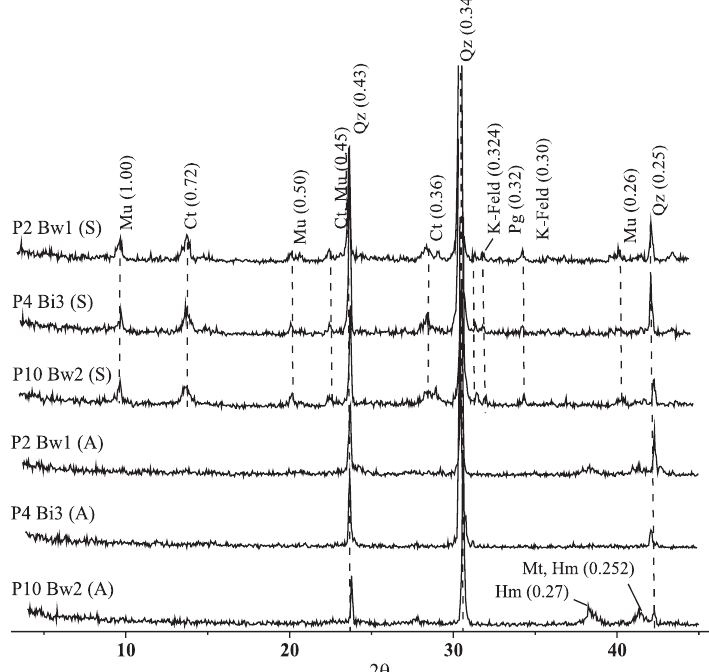
Figura 4. DRX representativos das frações silte (S) e areia (A) de LVA (P2), CX (P4) e LV (P10). Qz: quartzo; Mu: muscovita; Ct: caulinita; Pg: plagioclásio; K-Feld: feldspato potássico; Hm: hematita; Mt: